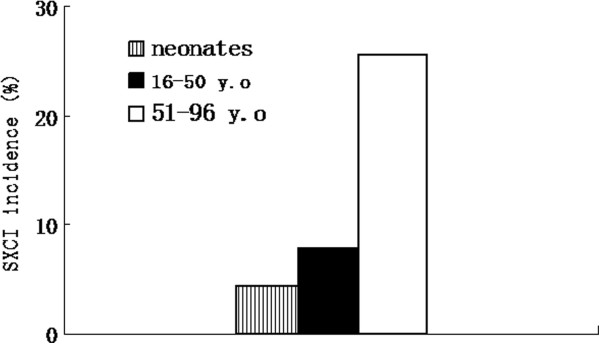
Incidence of SXCI (CR ≥ 3) in normal females from three age groups.